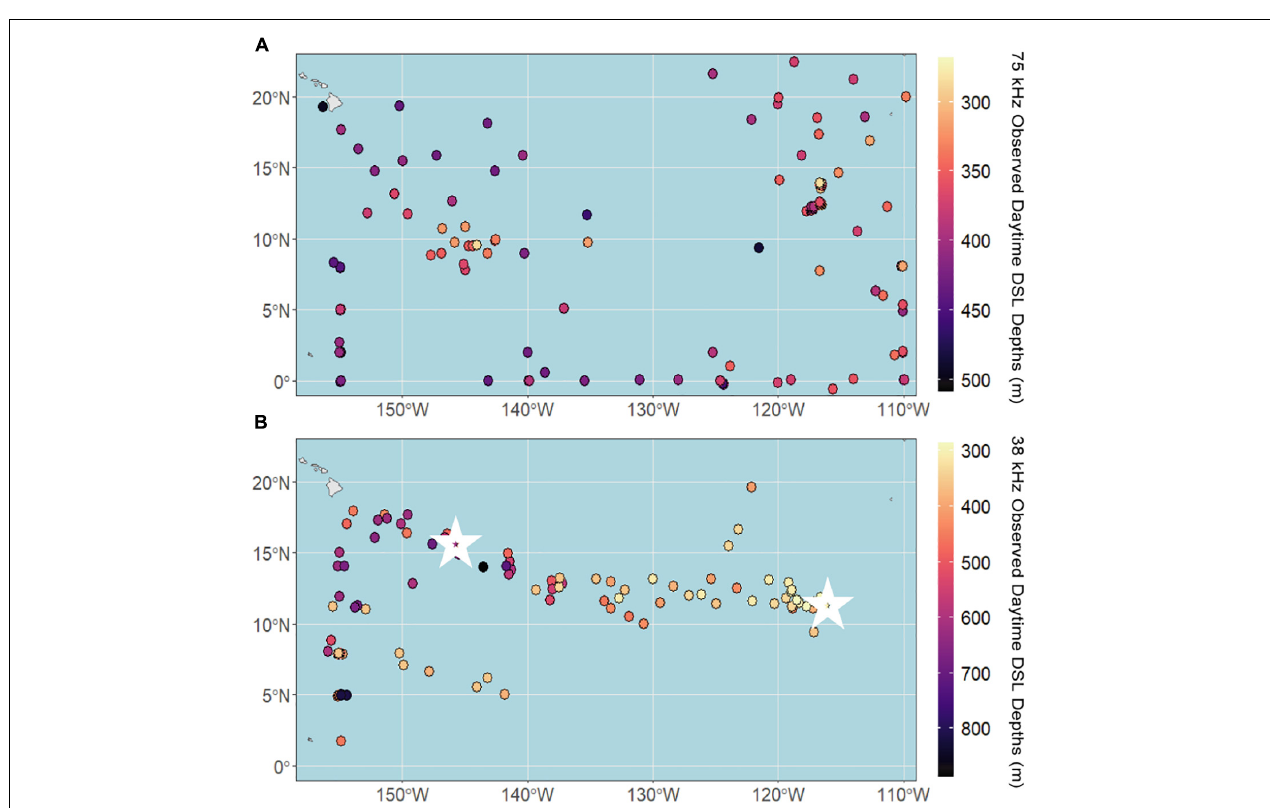
FIGURE 3 | Observed daytime deep scattering layer (DSL) depths across the CCZ region calculated from shipboard ADCP data between 2004 and 2019 at (A) 75 kHz and (B) 38 kHz. White stars indicate the locations of echogram examples ( Figure 2 ).